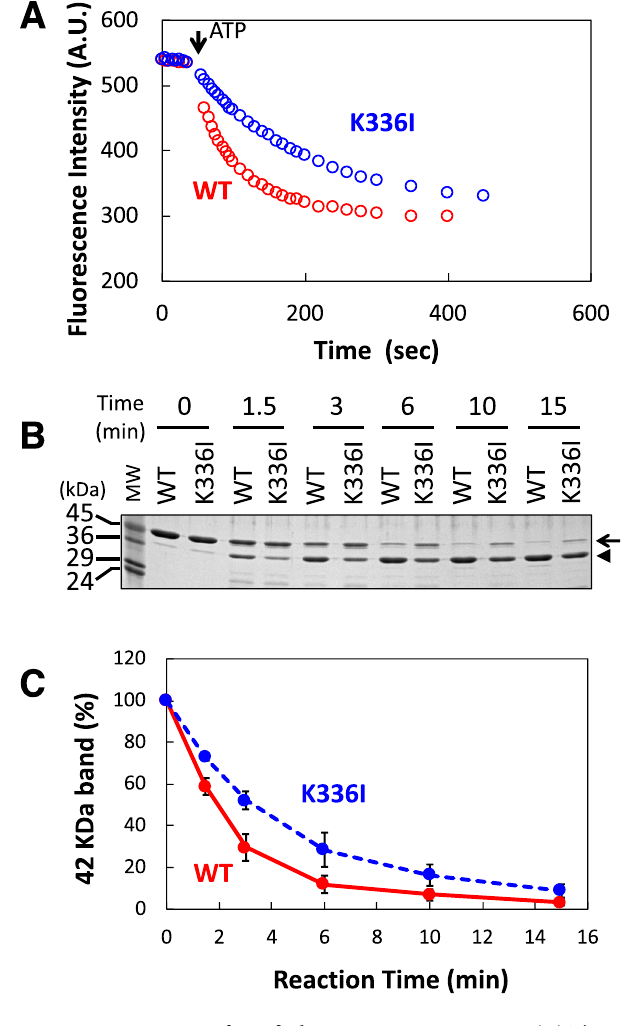
Figure 1. Properties of purified K336I monomeric actin. ( A ) The release rate of ε -ATP from K336I and WT actin monomers was monitored by measuring the decrease in fluorescence intensity after the addition of regular ATP (1 mM) to 20 µ M K336I or WT G-actin that had been incubated with ε -ATP. The dissociation rates of ε -ATP from K336I mutant actin and WT actin were 0.009 ± 0.001 s − 1 and 0.025 ± 0.005 s − 1 , respectively (mean ± SE, N = 3). There is a statistically significant difference between K336I and WT actin ( t -test, p < 0.01). ( B ) K336I and WT actin (4 µ M) were treated with 0.5 µ g/ml subtilisin for the indicated time, and analysed by SDS-PAGE. Arrows indicate intact actin bands (42 kDa) and arrowheads indicate digested actin bands (36 kDa). MW, molecular weight markers. Full-length gel image is shown in Supplementary Fig. S3. ( C ) Quantitation of intact actin bands from Coomassie-stained gels, including the one shown in ( B ). After 3 minutes of subtilisin digestion, 52.1 ± 4.3% of K336I G-actin was intact, vs. 29.6 ± 6.4% of WT G-actin (mean ± SE, N =